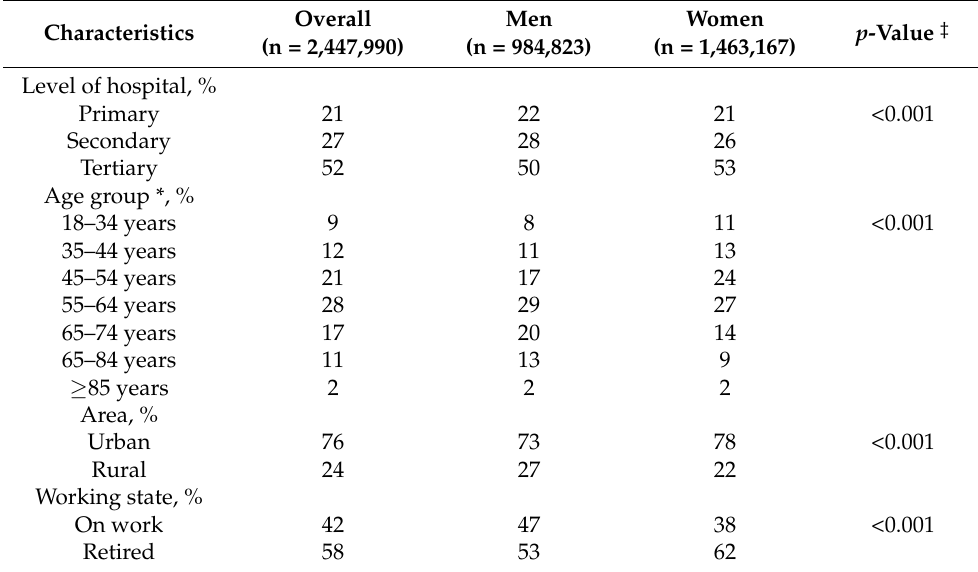
Table 1. Basic characteristics of people with knee osteoarthritis in Beijing, China, 2008–2017.